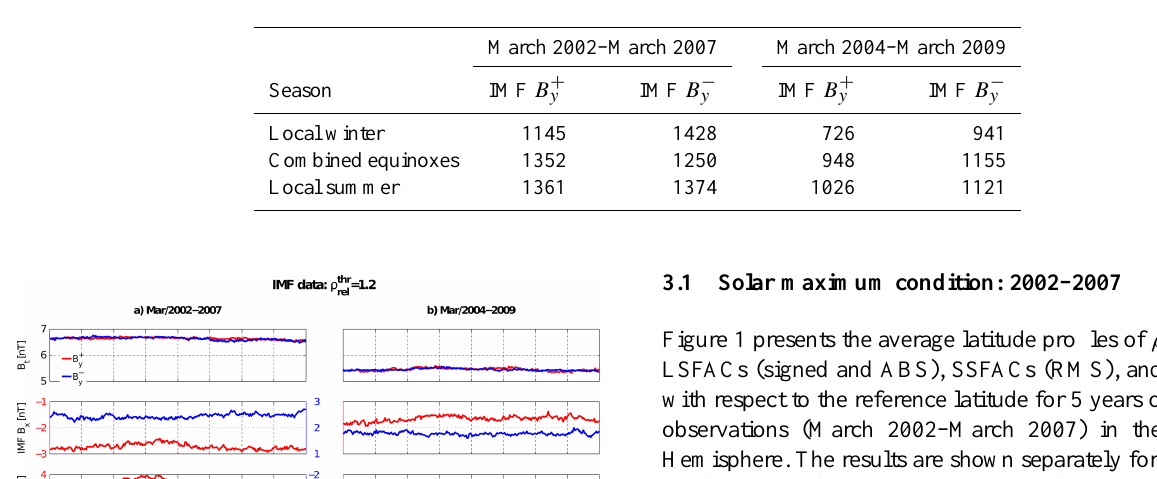
Table 1. The sample number distribution of prominent density enhancements, ρ pr maximum and minimum conditions for IMF B y sign and local season.